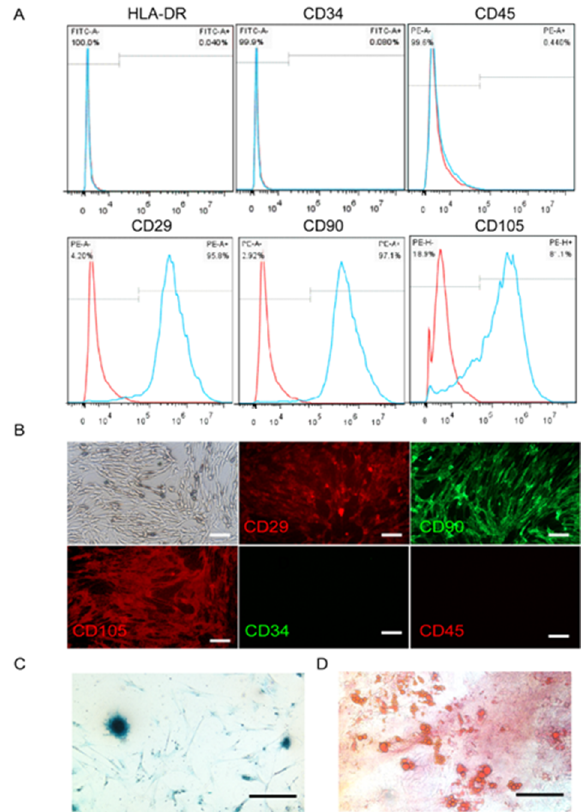
Figure 1. Characterization of umbilical cord mesenchymal stem cells (UC-MSCs). ( A ) Flow cytometry showing the percentage of cells expressing HLA-DR, CD-34, CD-45, CD90, CD29, and CD105. The cells also expressed CD90, CD29, and CD105, but not HLA-DR, CD34, or CD45. The red curve represents the blank, and the blue curve indicates positive expression. ( B ) UC-MSCs on glass slides were detected by fluorescence microscopy after hybridization with anti-CD antibodies (red: phycoreythrin (PE) label, green: fluorescein isothiocyanate (FITC) label). ( C ) Cartilage cells that differentiated from UC-MSCs were stained dark blue. ( D ) Adipocyte cells that differentiated from UC-MSCs were shown as red oil droplets.